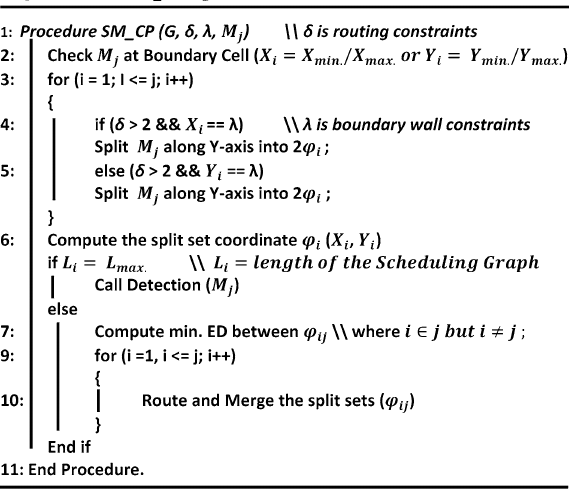
Fig. 14 Algorithm for new mixer droplet formation